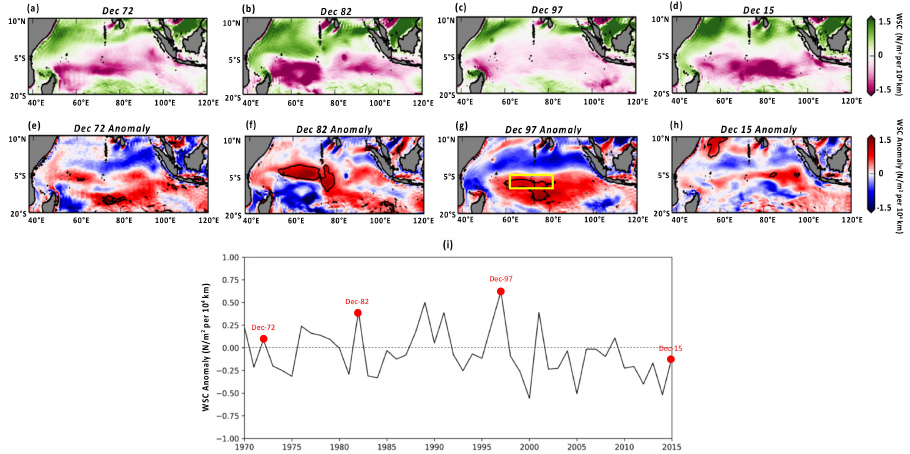
Figure 5. Wind Stress Curl (WSC) forcing over the Indian Ocean during super El Niño and strong IOD events. WSC during Decembers of ( a ) 1972, ( b ) 1982, ( c ) 1997 and ( d ) 2015 and their ( e,f,g,h ) associated anomalies (relatively to the period 1993–2015) are shown. The solid black contour lines indicate where anomalies are greater than two standard deviations. ( i ) Timeseries of the WSC anomalies averaged over the central Indian ocean area delimited by the yellow box shown on panel ( g ) for all Decembers of